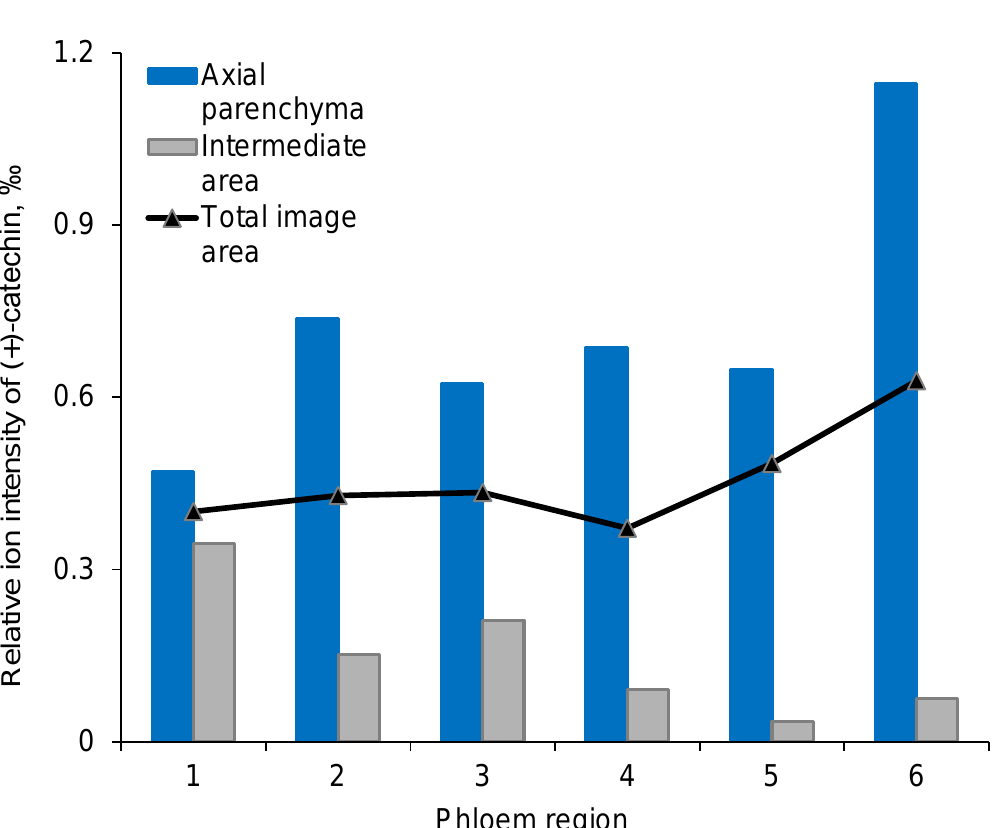
Figure 4. Relative ion intensity of (+) − catechin at m / z 291 as detected by ToF-SIMS in the regions of interest (ROI) in a non-treated, healthy tree. Axial phloem parenchyma (blue bars) and intermediate areas (gray bars) composed of sieve cells and ray parenchyma at the radial-longitudinal phloem surface of an older Norway spruce tree from the cambium and non-collapsed phloem on the left ( 1 ) to the inner ( 2 ), middle ( 3 – 4 ), and outer ( 5 ) regions of the collapsed phloem, with the outermost collapsed phloem and periderm ( 6 ) on the right. The black line represents the relative ion intensity of (+) − catechin in the total image area in each phloem region. The phloem regions are the same as those shown in Figure 3. The relative ion intensities were computed per mL of the total ion counts in each image or ROI. The ion intensities of (+) − catechin were statistically higher in the axial parenchyma than in the intermediate spaces ( p < 0.001).